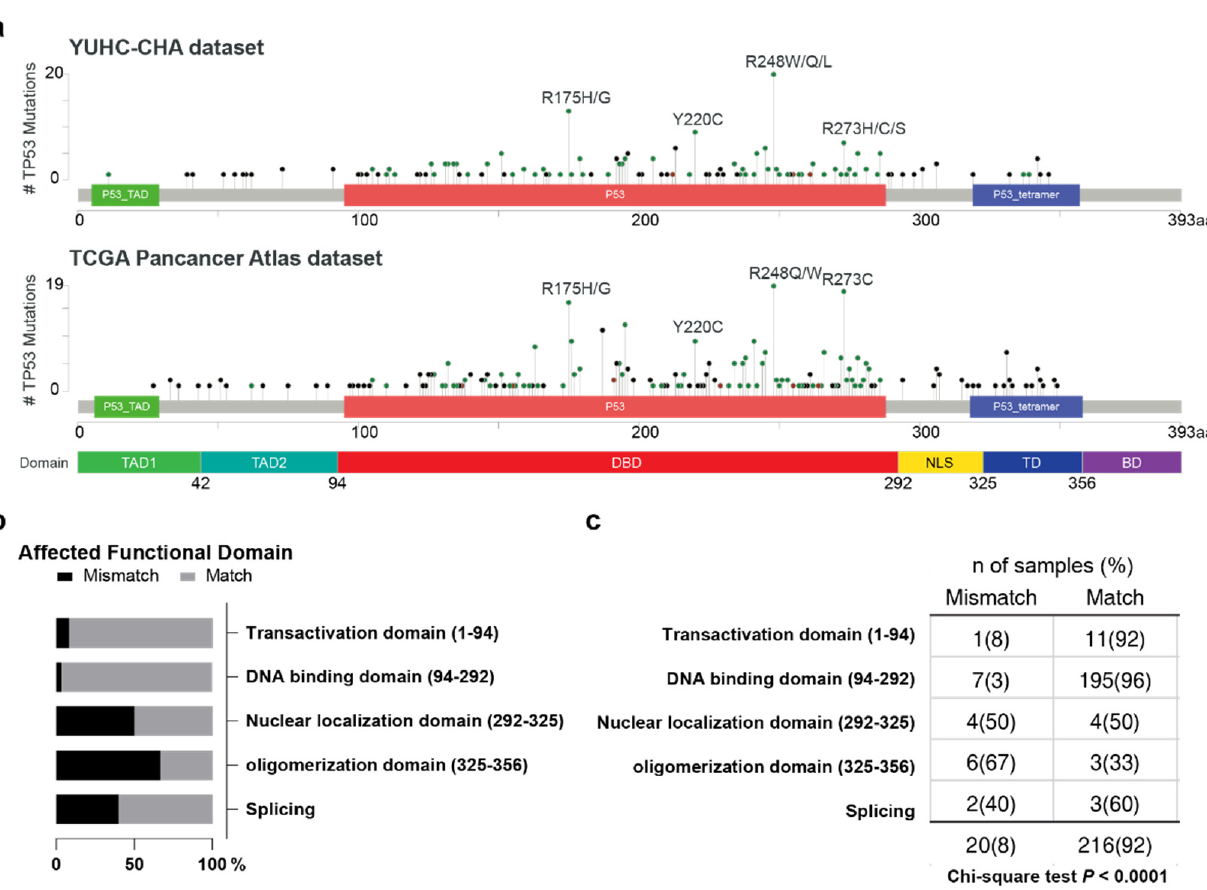
Figure 3. ( a ) Lollipop plot of TP53 mutation frequencies by their domain site reported in this study and the TCGA ovarian serous cystadenocarcinoma dataset. NLS = nuclear localizing site; OD = oli- gomerization domain. ( b , c ) Distribution of p53 IHC staining and NGS mutation concordance rate. Chi-square test.